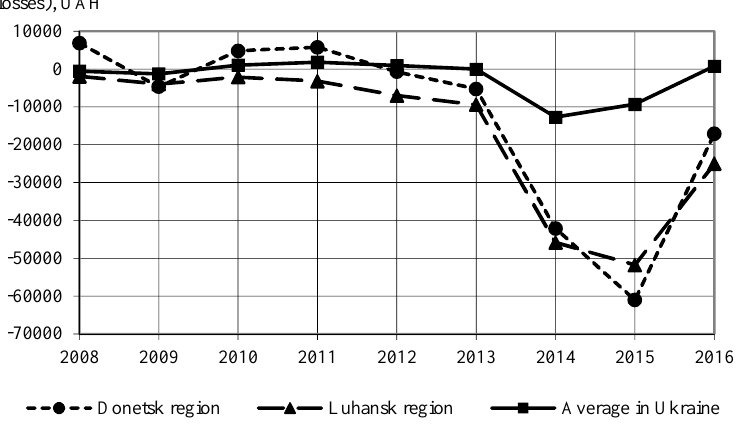
Figure 3. Dynamics of net profit (losses) of enterprises of Luhansk and Donetsk regions compared to average value in Ukraine